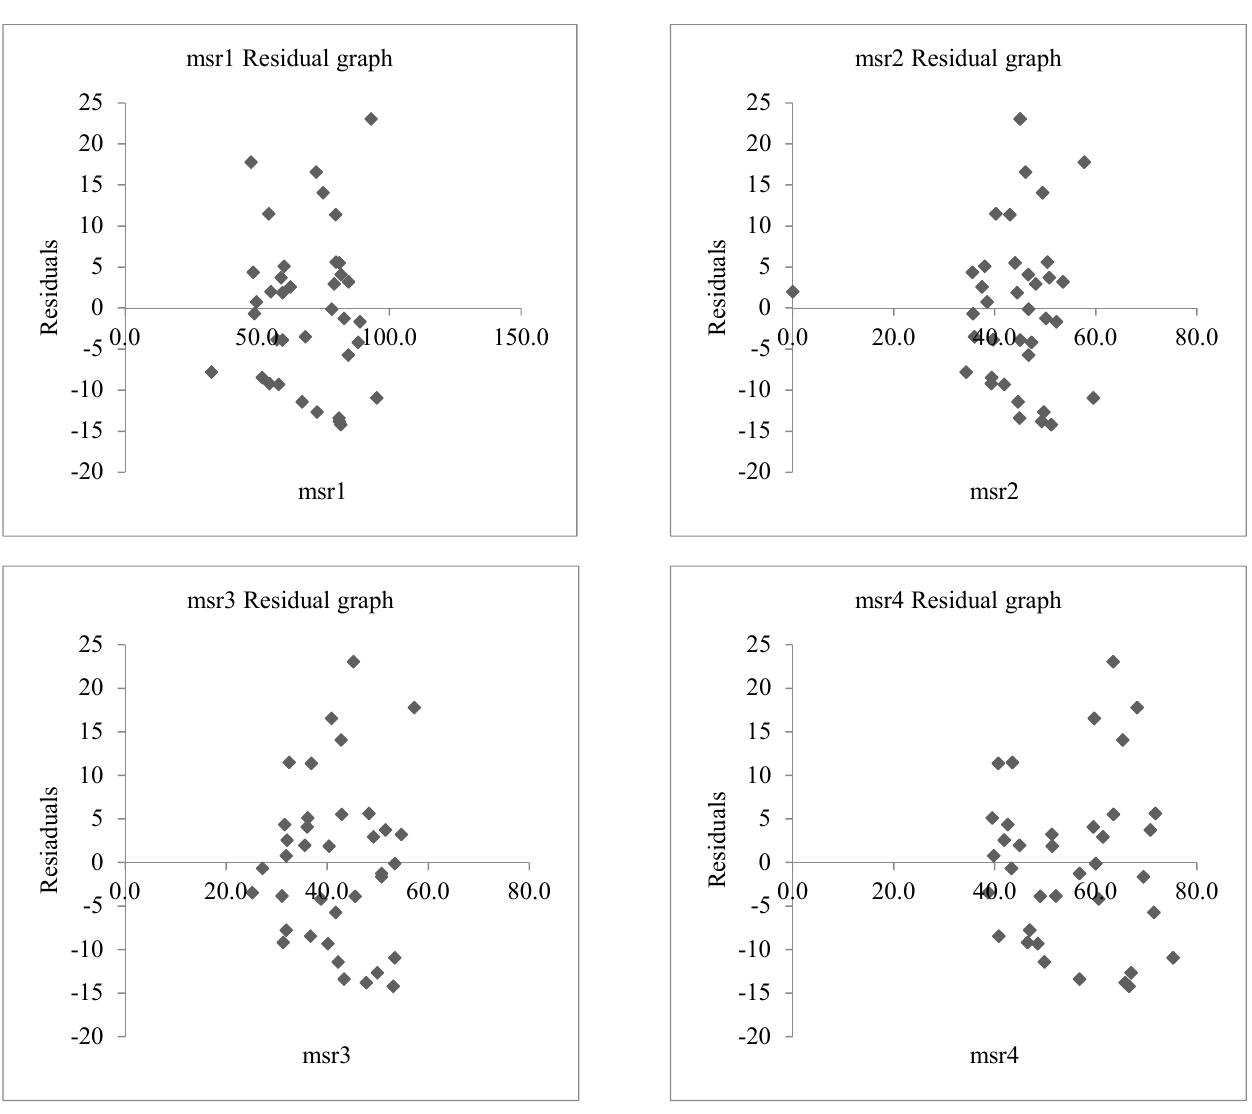
Figure 6. Residual graphs. Source: Obtained by the authors automatically with the help of the “Regression” function in Microsoft Excel.